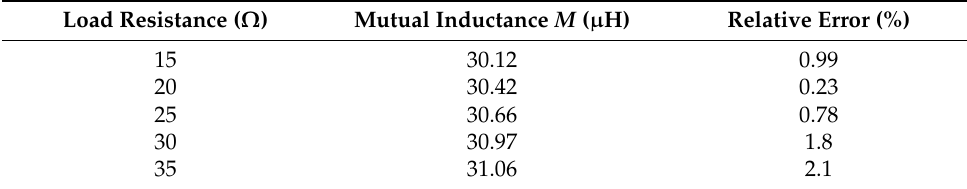
Table 2. The identification values of M under different load resistance.